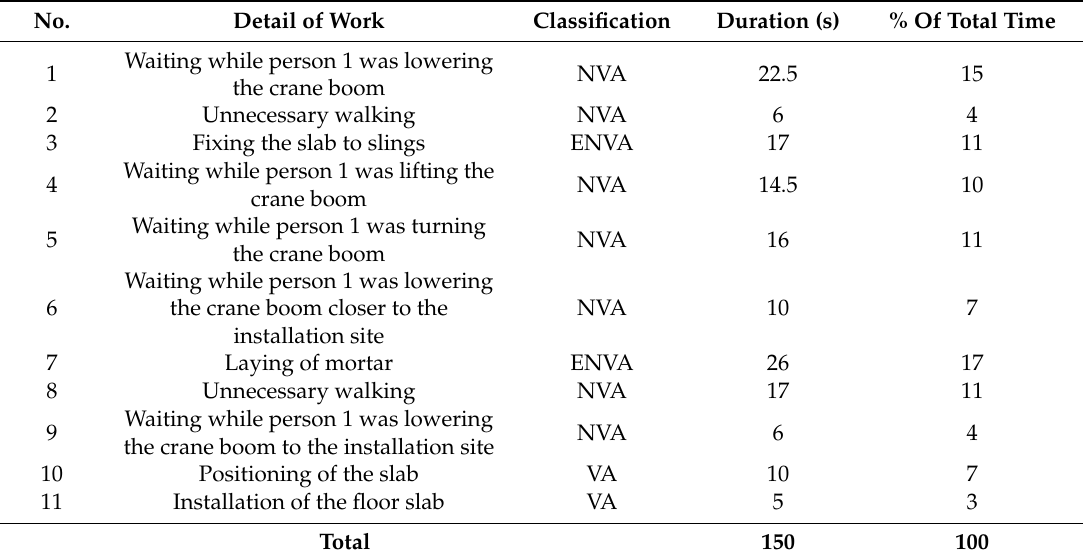
Table 2. Average data gathered from the VSM of the process “installation of a floor slab” for person 2 (installation